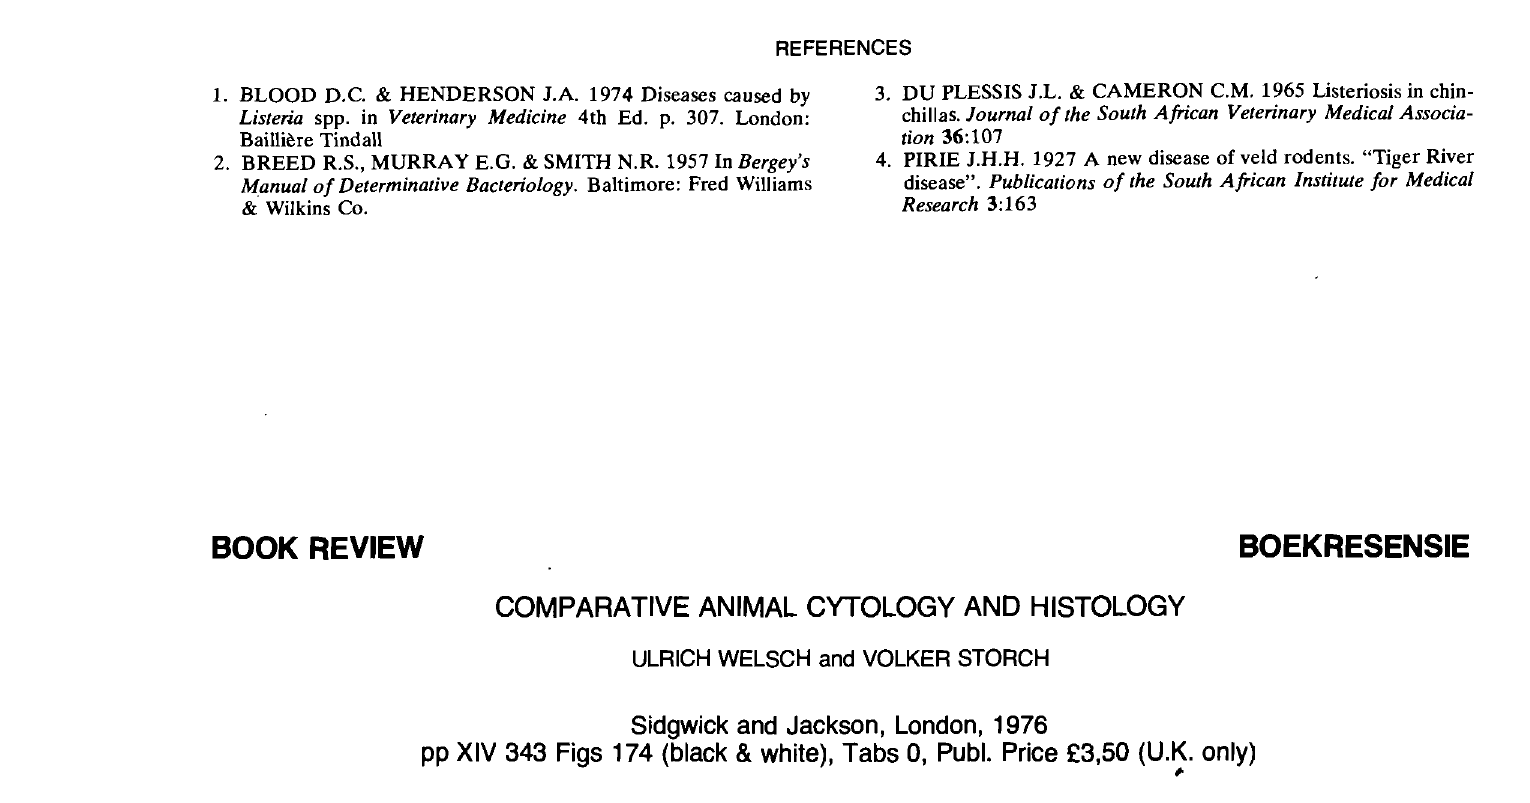
pp XIV 343 Figs 174 (black & white), Tabs 0, Pub!. Price £3,50 (U.K. only)